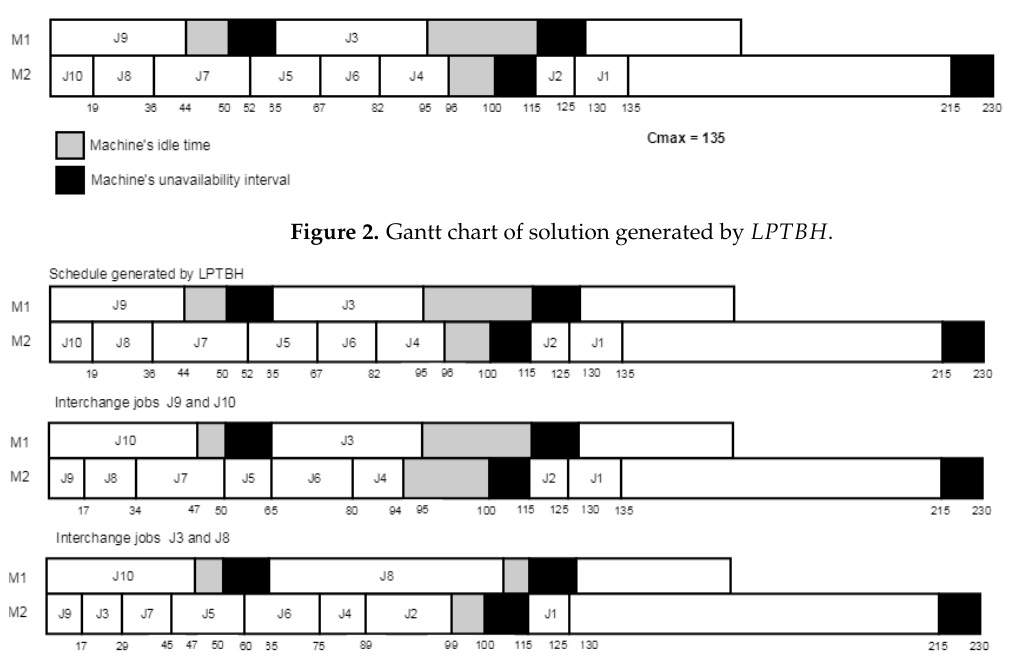
Figure 3. Gantt chart of the solution generated by LSHIP